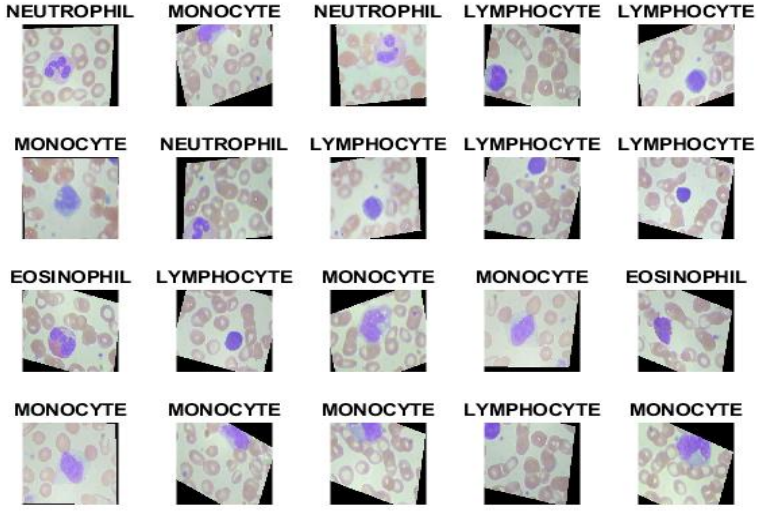
Figure 3. Sample dataset after the optimization process.